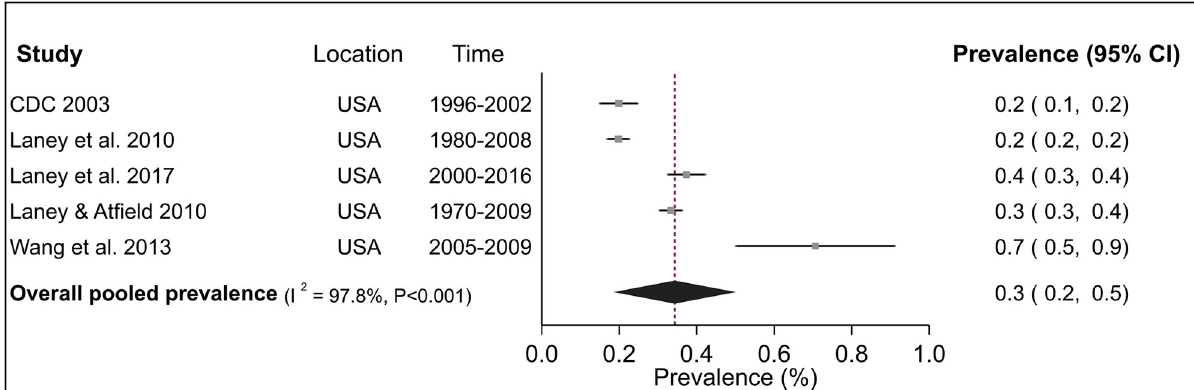
Fig 3. Forest plot from meta-analysis for overall prevalence of progressive massive fibrosis (PMF) in the United States (USA). The red dashed line corresponds to the overall effect size to guide the eye.